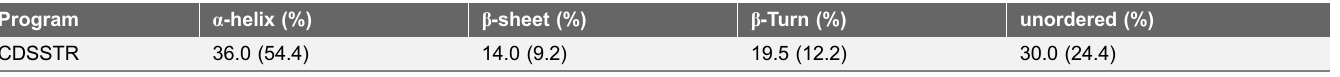
Table 2. Results of CD spectral analysis of C-214-HrpZ Pss